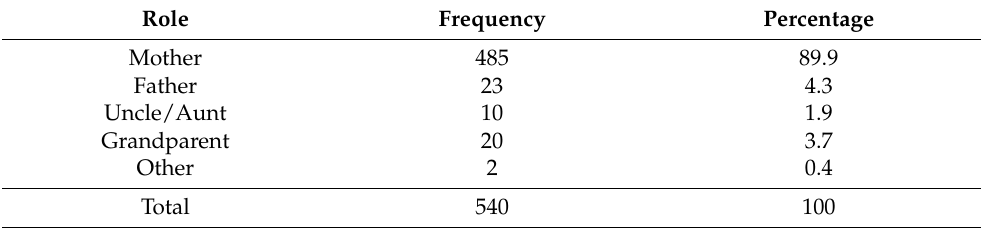
Table 2. Role of